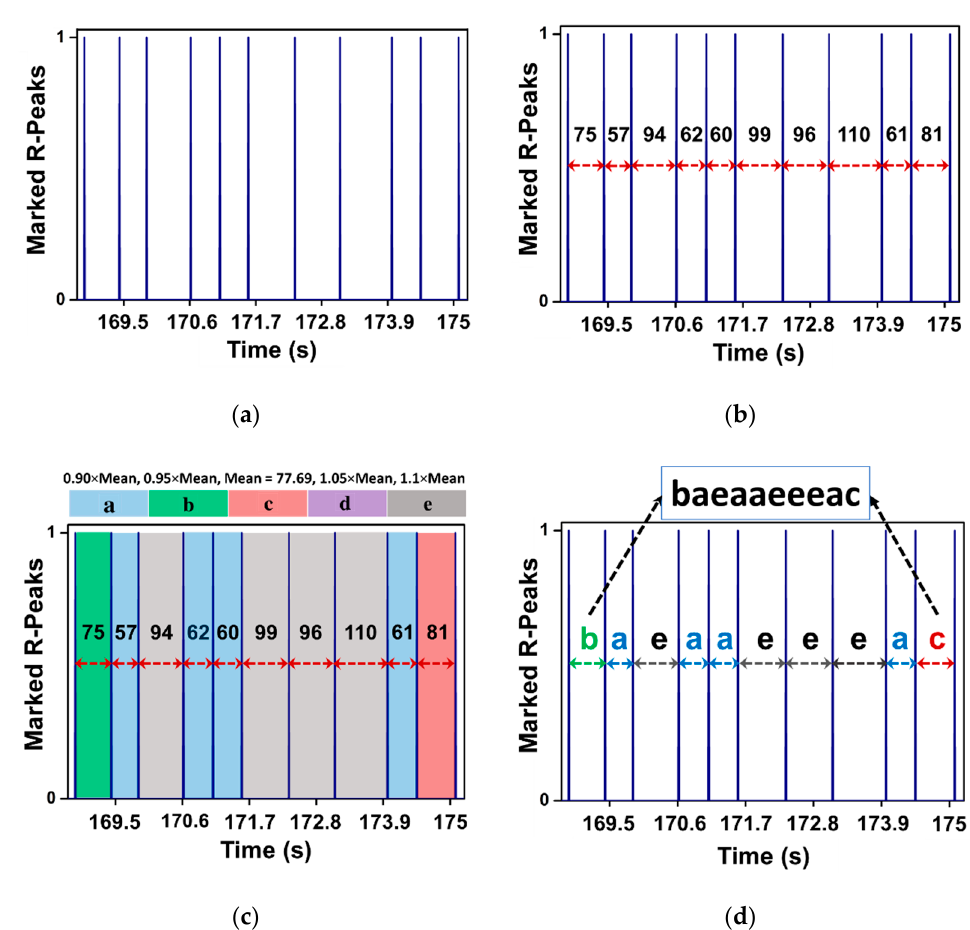
Figure 2. The pipeline of the dynamic symbol assignment (DSA) approach; representative RR intervals as input to the DSA method ( a ), distance evaluation of the input data ( b ), distance approximation using dynamic threshold lists ( c ), and representation of symbolic sequence after symbolization ( d ).